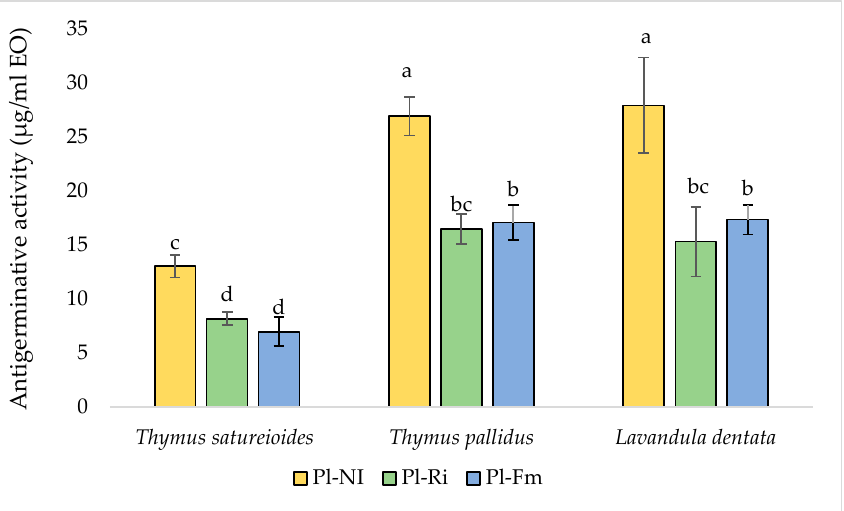
Figure 9. Anti-germinative activity of the essential oil of Thymus satureioides (Ts), Thymus pallidus (Tp), and Lavandula dentata (Ld), non-inoculated (NI) or inoculated with Rhizophagus irregularis (Ri)